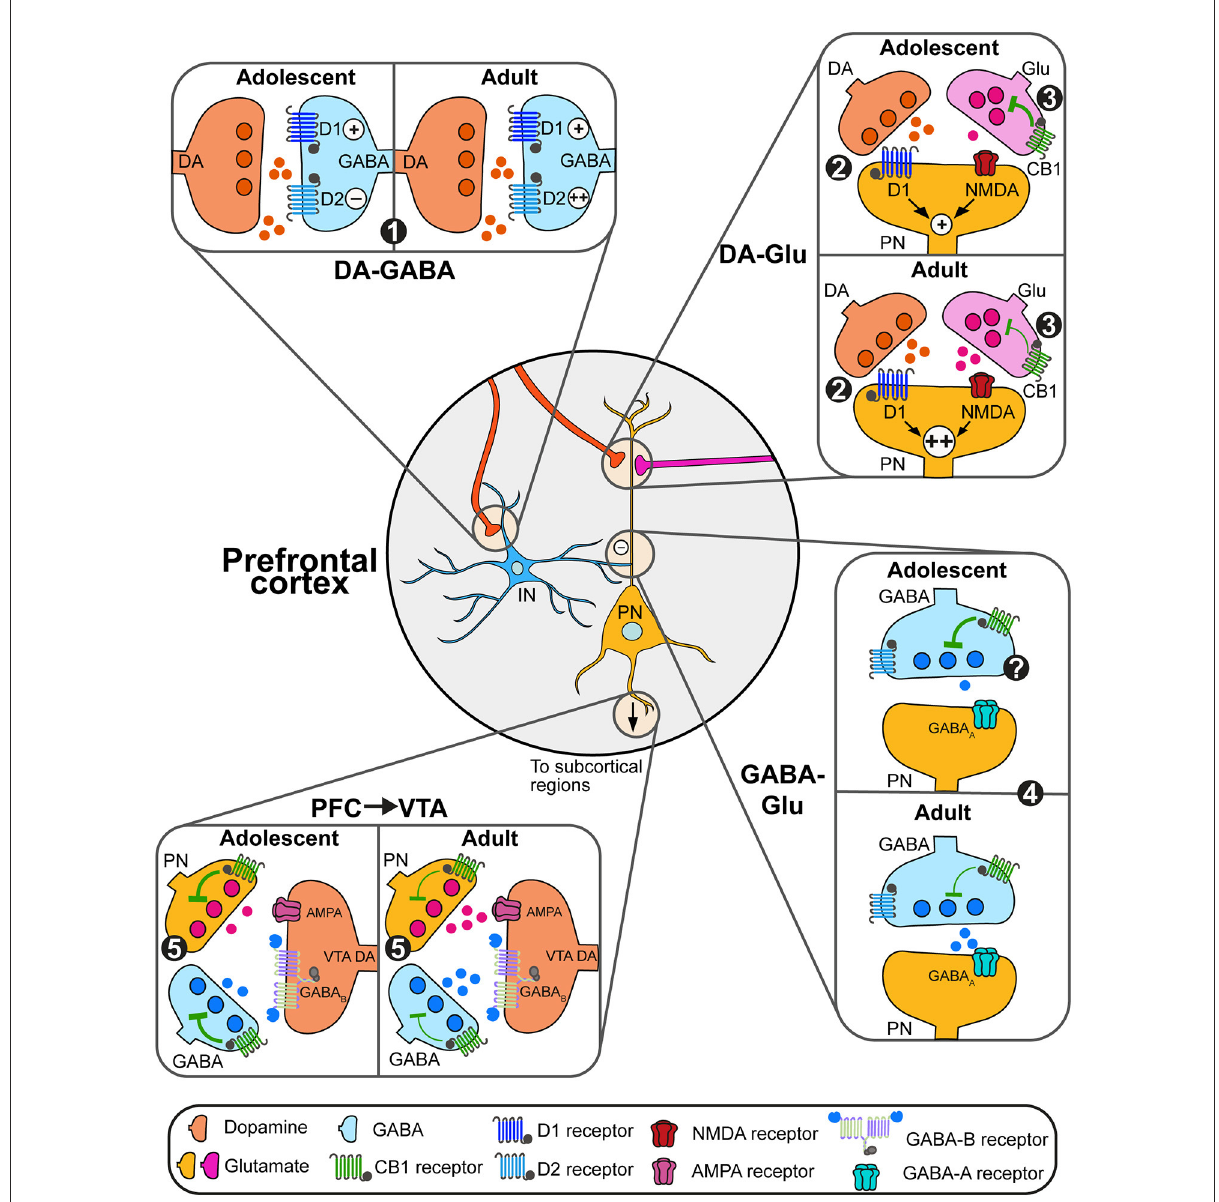
FIGURE2 Adolescent changes in the modulation of prefrontal circuits by dopamine and endocannabinoids. (1) During adolescence, dopamine (DA, orange) increases the excitability of prefrontal GABAergic interneurons (blue) solely through D1 actions. At adulthood, dopamine facilitates interneurons excitability through both D1 and D2 receptors, which may change GABAergic control of pyramidal neuron (PN) activity. (2) Dopamine actions through D1 receptors enhance glutamatergic NMDA signaling on glutamate (Glu, pink and orange) neurons. This effect is more robust during late adolescence/adulthood, allowing the emergence of persistent depolarizations of pyramidal neurons (PN, orange). (3) eCB retrograde control (green) of glutamate transmission decreases between adolescence and adulthood, likely due to changes in expression levels of CB1 receptors. (4) At adulthood, the combined action of dopamine on D2 receptors and eCB signaling control the activity of plasticity of GABAergic synapses on PN. Changes in this process during adolescence remain to be demonstrated. (5) PN controls the activity of subcortical circuits. Within the VTA for instance, both PN glutamate transmission and local GABAergic transmission control the activity of DA neurons and DA release. Developmental changes in eCB signaling through the expression of CB1 receptors on PN and GABAergic neurons may change this